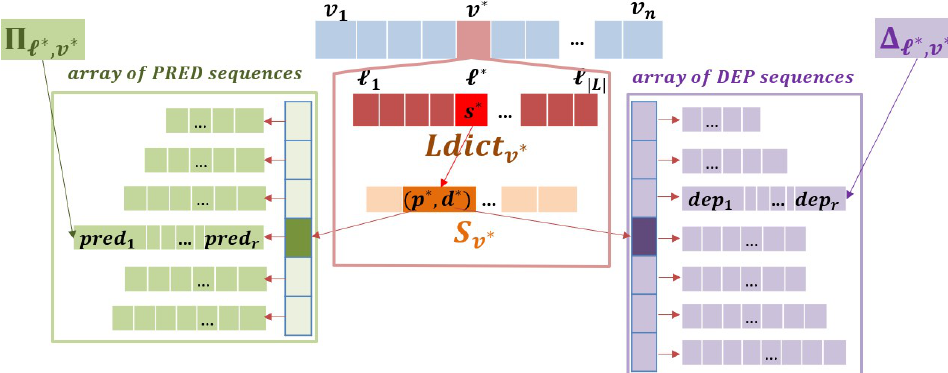
Figure 2. Data structure for the succinct representation of preprocessed information of